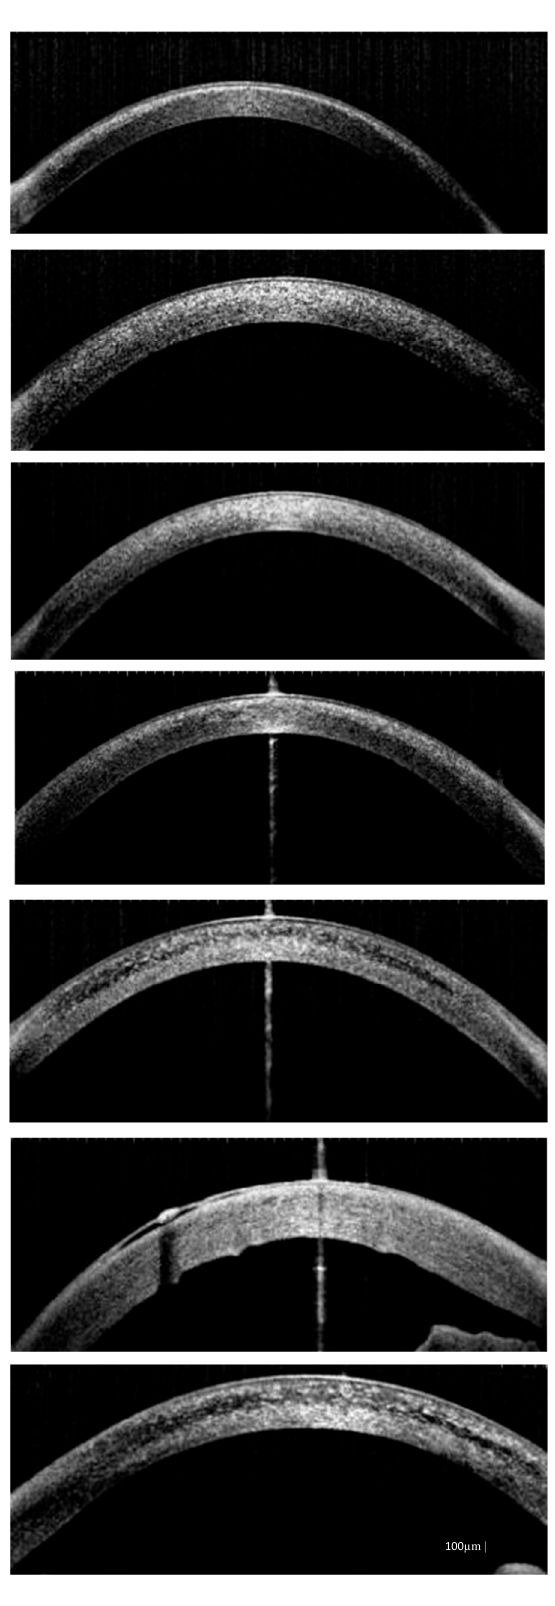
Figure 4. Anterior segment optical coherence tomography (AS-OCT) images showing deep corneal cystine crystals (CCC) in studied patients (from the top: P1, P2, P3, P4, P5, P6, P7). Band keratopathy and thickened cornea are visible in patient P6 as complications of long-term cystinosis.